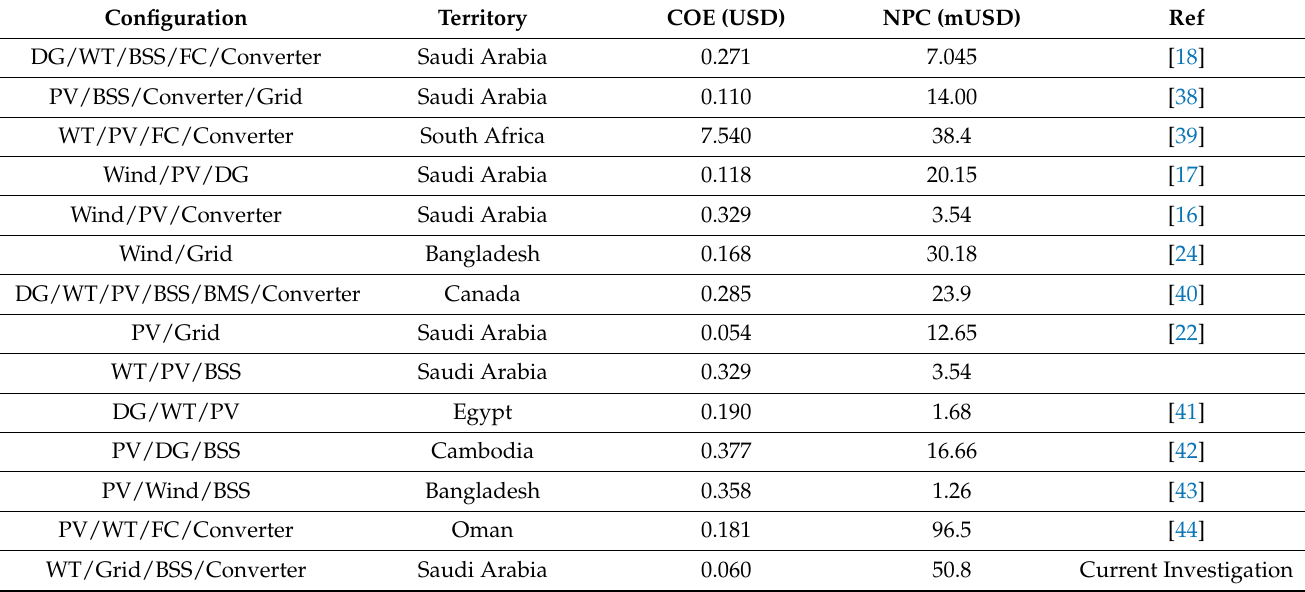
Figure 15. Cost summary. Table 3. Different scenarios of previous studies and the proposed